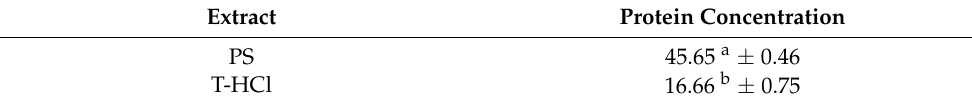
Table 5. Protein concentration of the aqueous extracts from P. cruentum ( µ g · mL − 1 ). Extract Protein